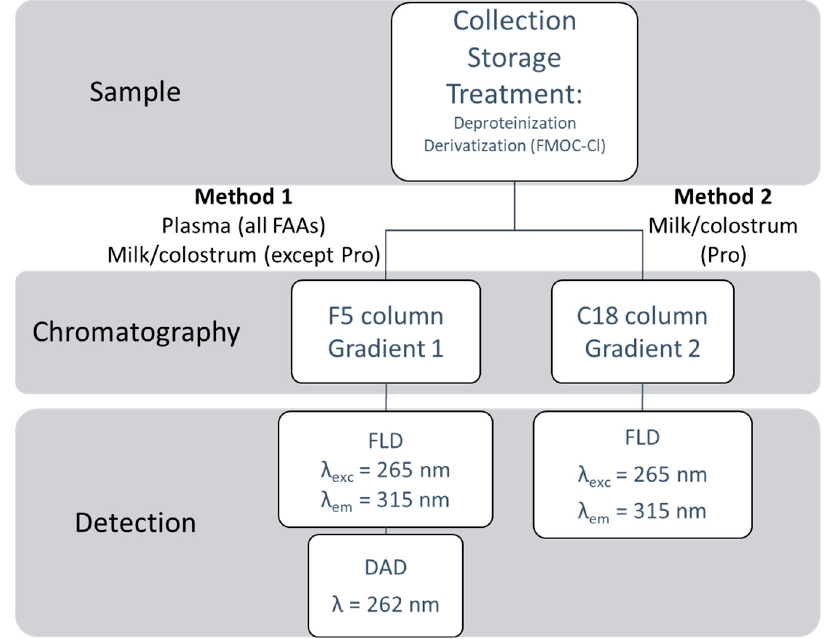
Figure 2. Workflow for the analysis of the 20 FAAs in milk, colostrum and plasma.